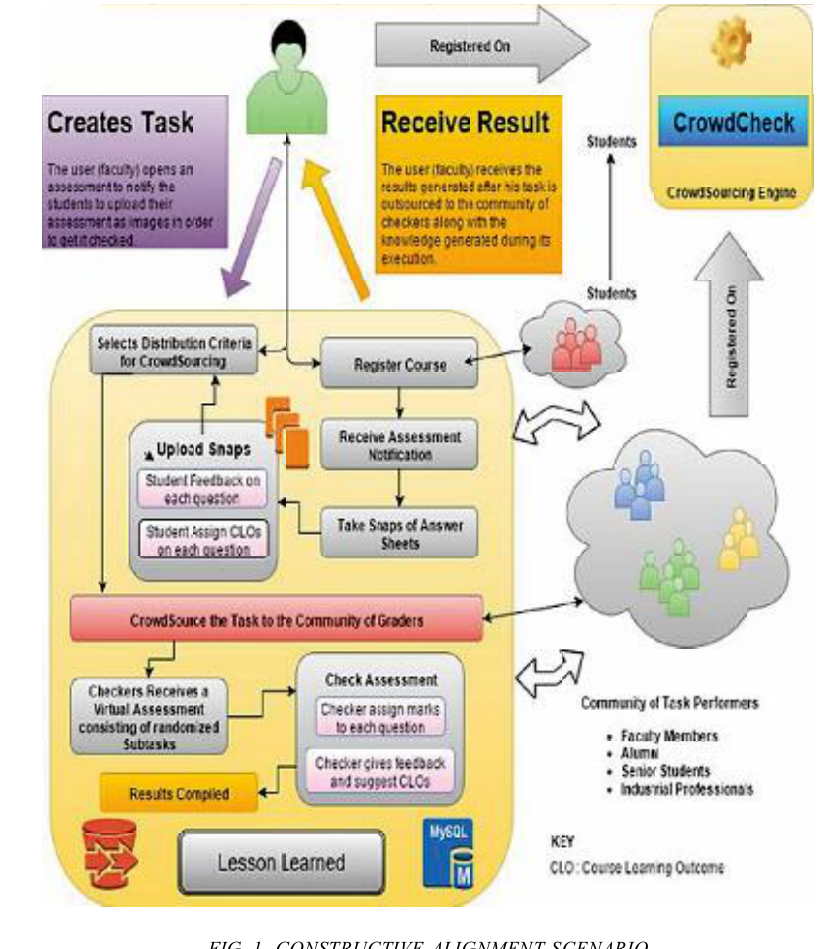
FIG. 1. CONSTRUCTIVE ALIGNMENT